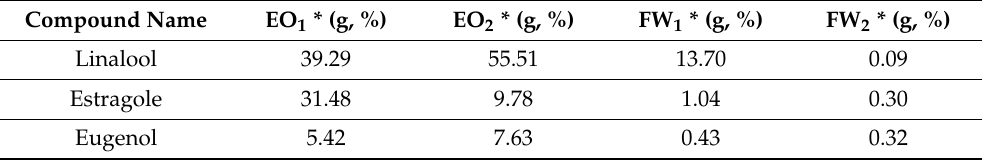
Table 4. Quantitative dosage of the main three compounds (linalool, estragole, eugenol) found in basil extracts.